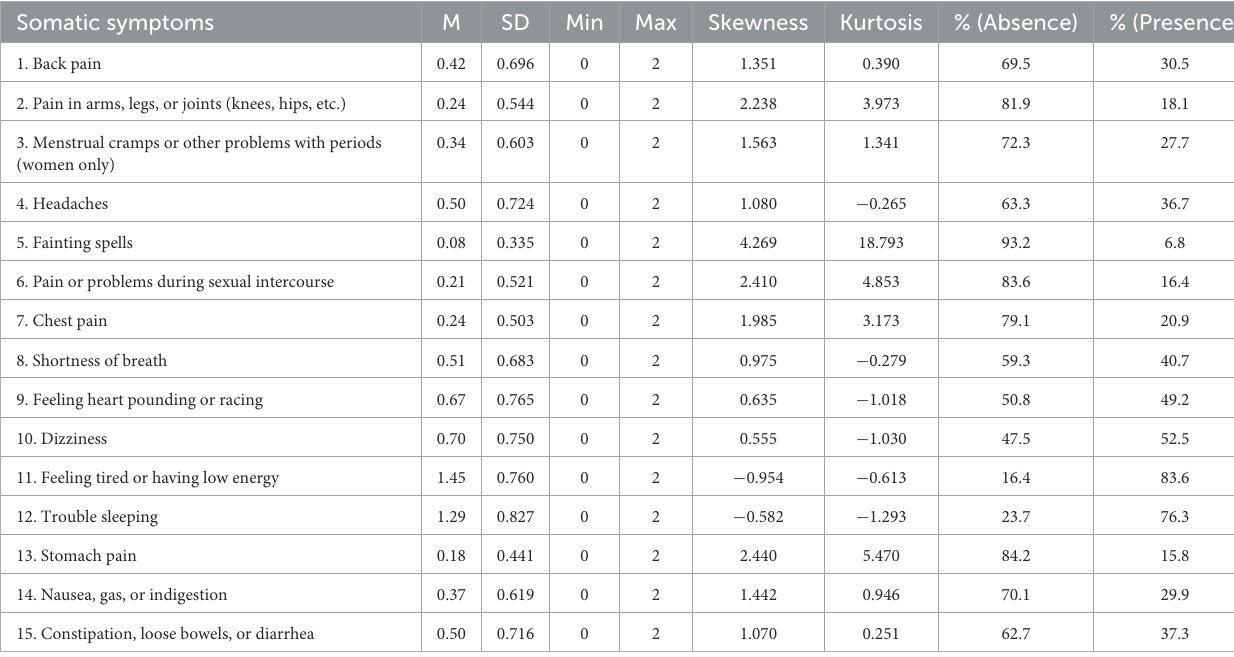
TABLE 2 Item description of somatic symptoms as measured by the PHQ-15 ( N =